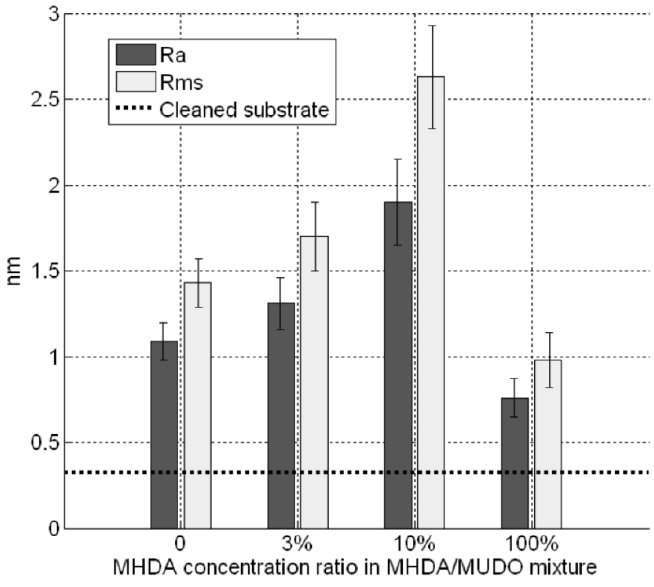
Figure 4. GaAs surface roughness after protein incubation on different chemical